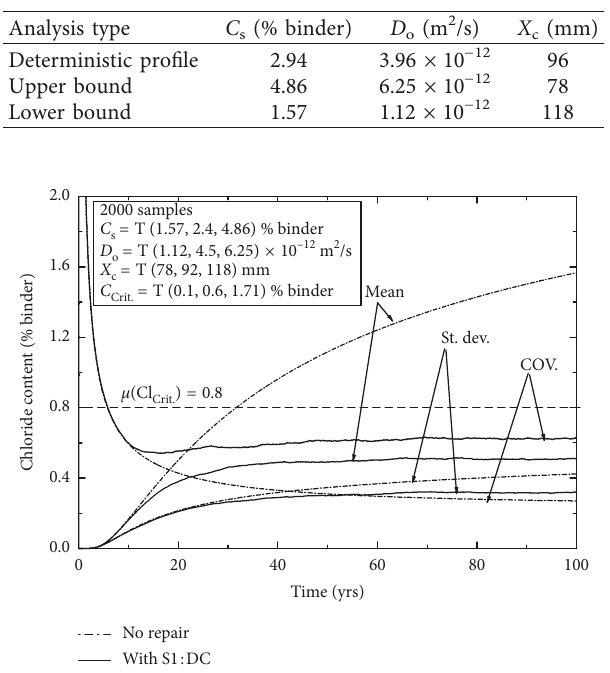
Figure 8: Probabilistic time-dependent chloride profiles without and with S1.